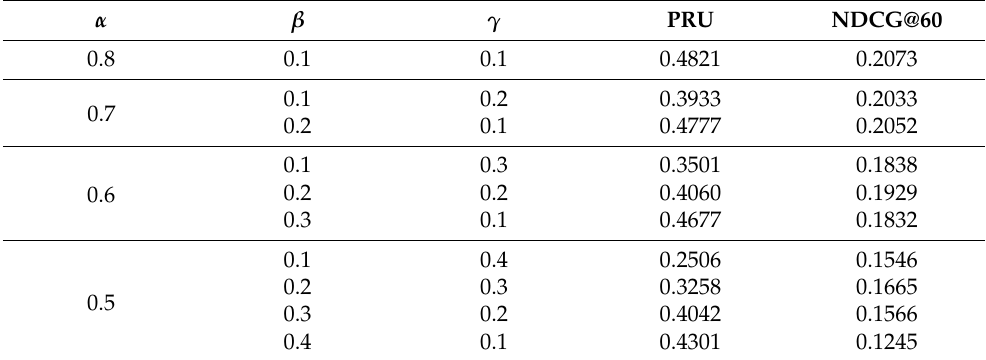
Table 2. The weights α , β and γ of the three intervals of strong, medium, and weak psychological tendency were adjusted, respectively, according to the step size of 0.1, and PRU and NDCG were used as evaluation